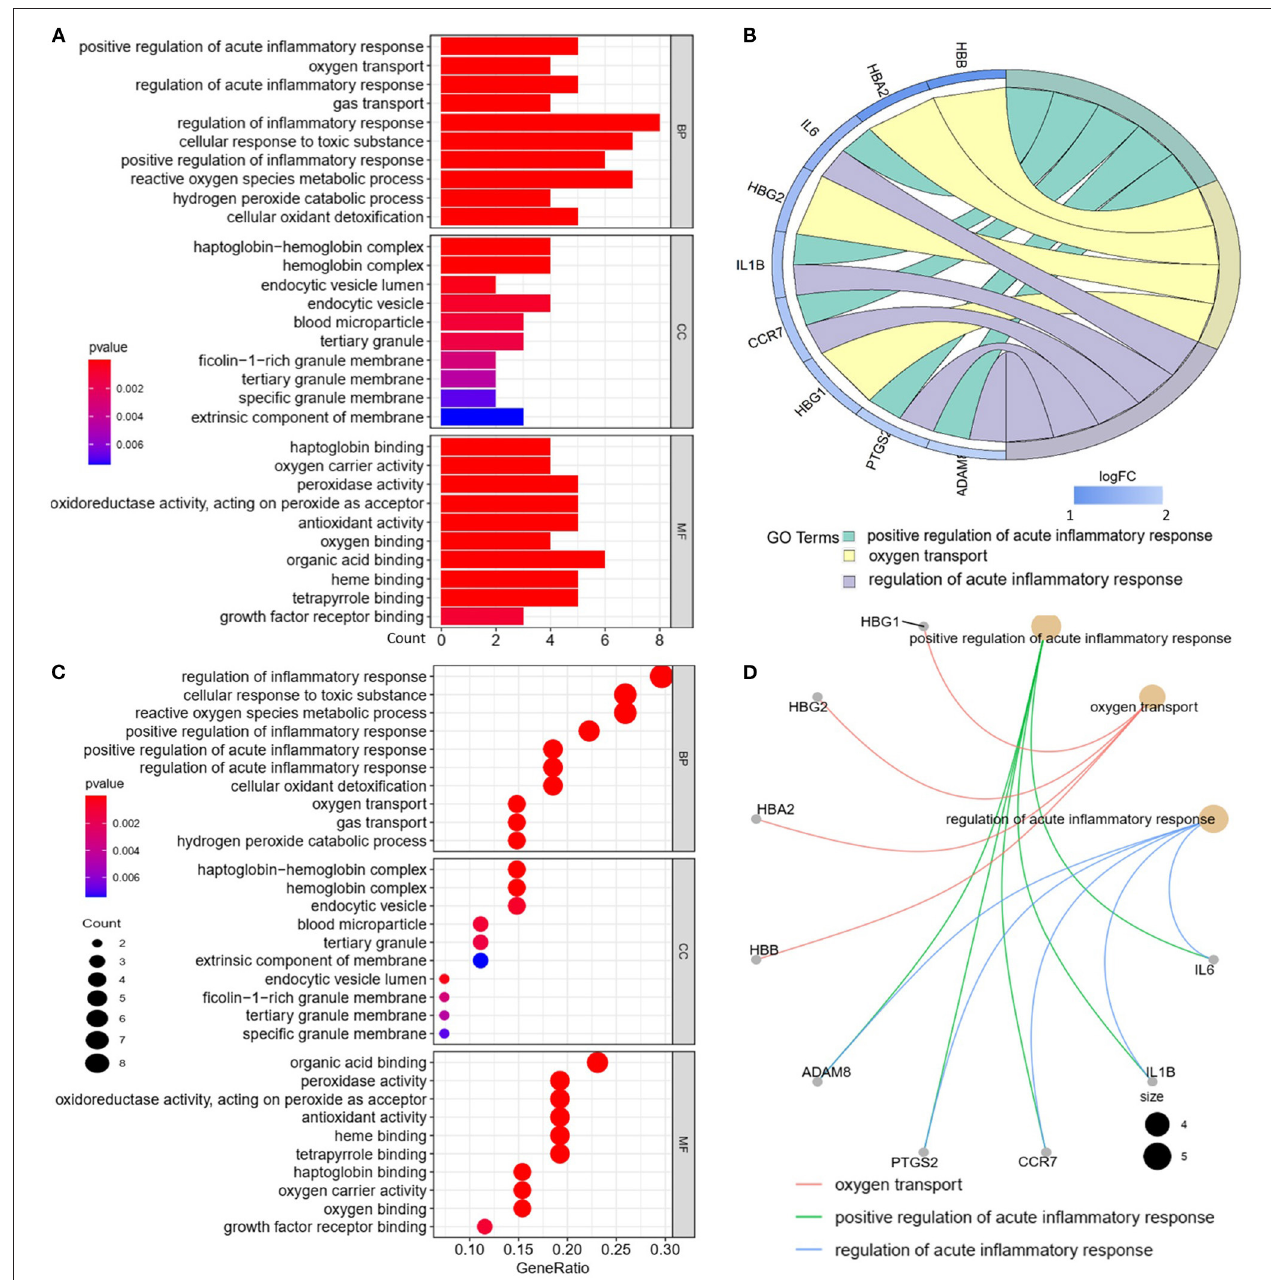
FIGURE 2 | Gene Ontology (GO) analyses of the upregulated differentially expressed genes (DEGs) between abdominal aortic aneurysm (AAA) and health control (Normal) in the biological processes (BPs), cellular components (CCs), and molecular functions (MFs). (A) GO histogram plot: the y-axis represents the term where genes are enriched, and the x-axis represents the gene enrichment number to the corresponding term. The color of the column represents the p -value. (B) The top 3 enriched GO terms. GO chord plot: the genes are linked via ribbons to their assigned terms. Red coding next to the selected genes indicates logFC. (C) GO bubble plot: the y-axis represents the term where genes are enriched, and the x-axis represents the ratio of term genes to the total genes. The color of the dot represents the p -value, and the size of the dot represents the number of gene enrichment. (D) The top 3 enriched GO terms. GO cnetplot: the genes are linked via lines to their assigned terms. The size of the dot indicates the number of genes enriched to the corresponding